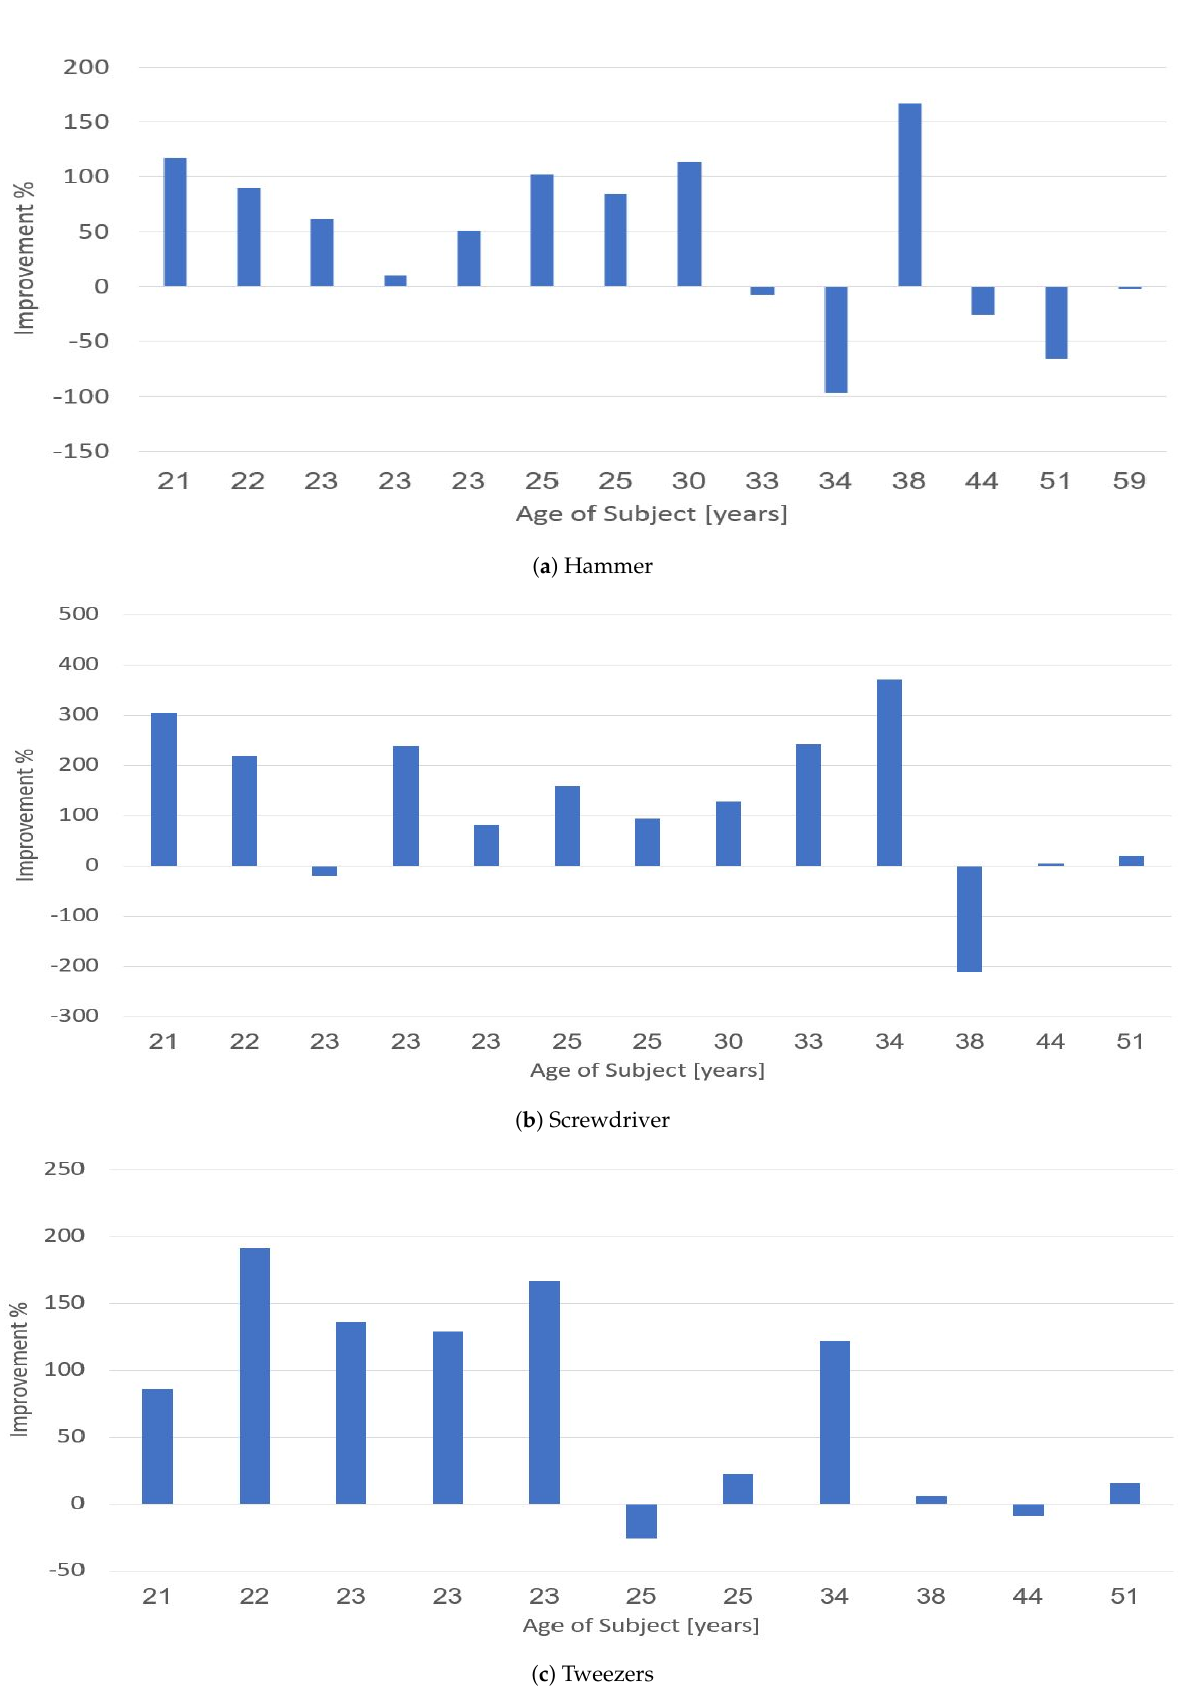
Figure 11. Improvement per subject in power